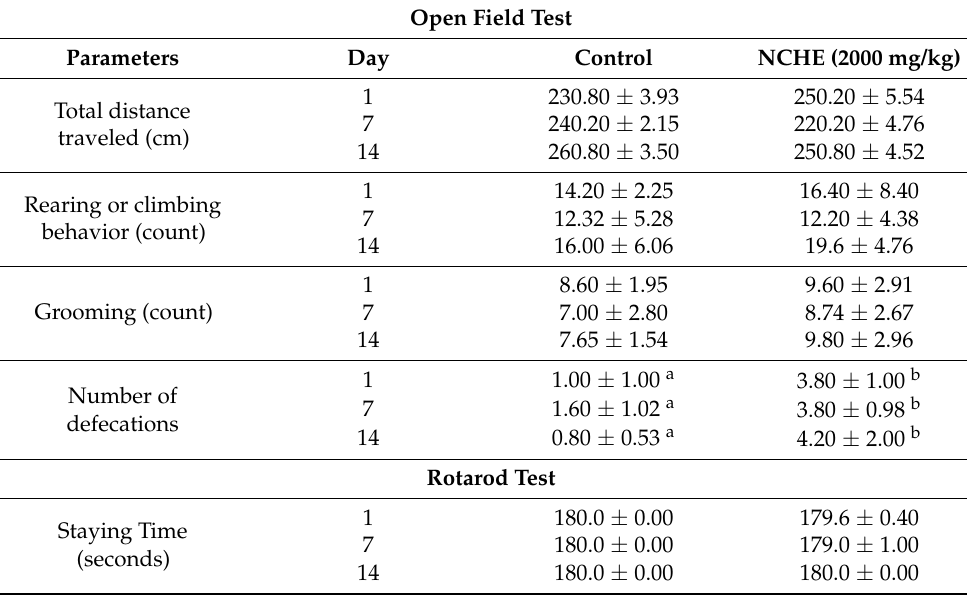
Table 4. Behavioral evaluation in the open field test and motor activity evaluation in the rotarod test in rats on days 1, 7 and 14 post-treatment with N. cochenillifera hydroethanolic extract (NCHE) in a single oral dose (2000 mg/kg).